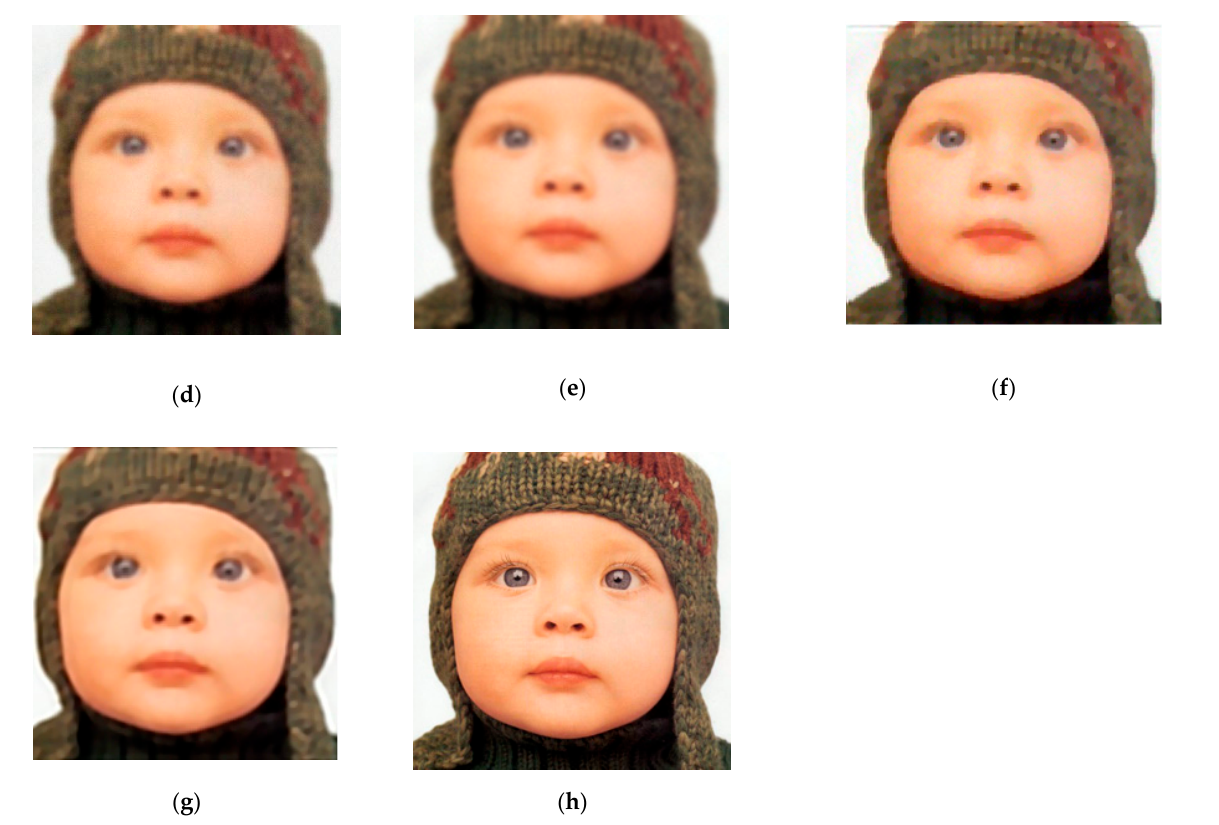
Figure 5. Visual comparison of algorithms for the Baby image with σ noise = 0.025 when the mag- nification factor is 4. ( a ) The LR image; ( b ) Bicubic interpolation; ( c ) BayesSR; ( d ) SRB; ( e ) DeepSR; ( f ) FBSR; ( g ) Ours; ( h ) ground truth.